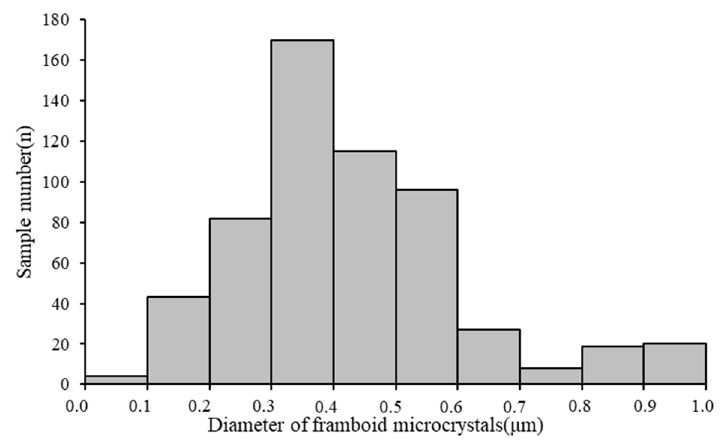
Figure 5. Distribution of the diameter of the framboid microcrystals in the Wufeng and Longmaxi